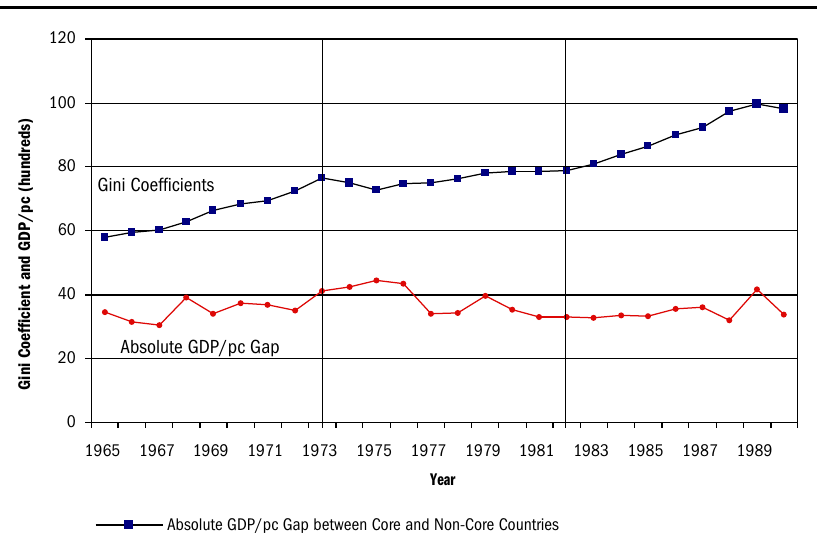
Figure 2 – The Absolute GDP/pc Gap and Average Gini Income Inequality Scores, 1965–1990 (=72)